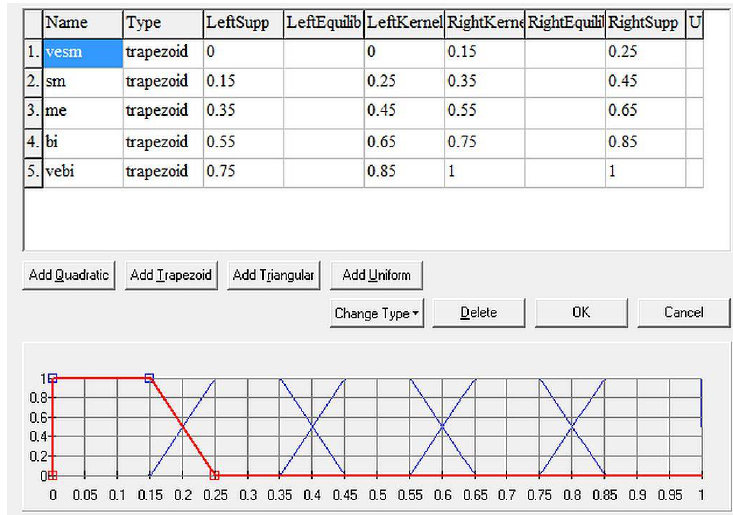
Figure 4. Graphic representation of the input value set V3.